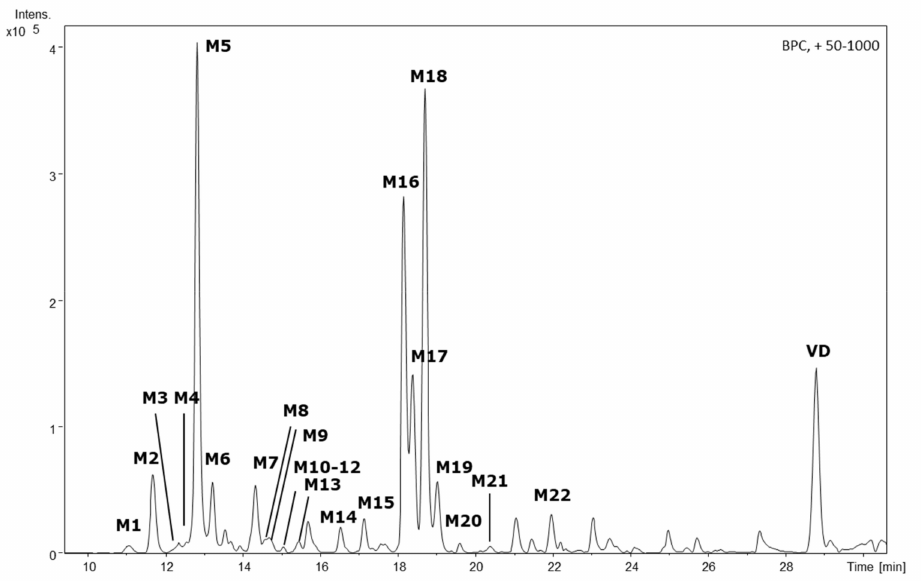
Figure 1. HPLC-QTOF-MS-derived base peak chromatogram of the HLM incubation supernatant featuring the parent compound vitetrifolin D (VD) and its phase I metabolites M1–M22. Experimental conditions HPLC: column: Zorbax Eclipse XDB-C18, 3 × 100 mm, 3.5 µ m; mobile phase: A: H 2 O, B: acetonitrile, gradient: 0 min: 80% A, 5 min: 80% A, 8 min: 65% A, 35 min: 2% A; temp: 25 ◦ C; flow rate 0.3 mL/min; injection volume:10 µ L. HR-MS: ESI, positive mode; nebulizer gas (N 2 ) 30.5 psi, dry gas (N 2 ) 8.0 L/min at 220 ◦ C, capillary voltage 4.5 kV; mass scan range: 50–1000 m / z at 1